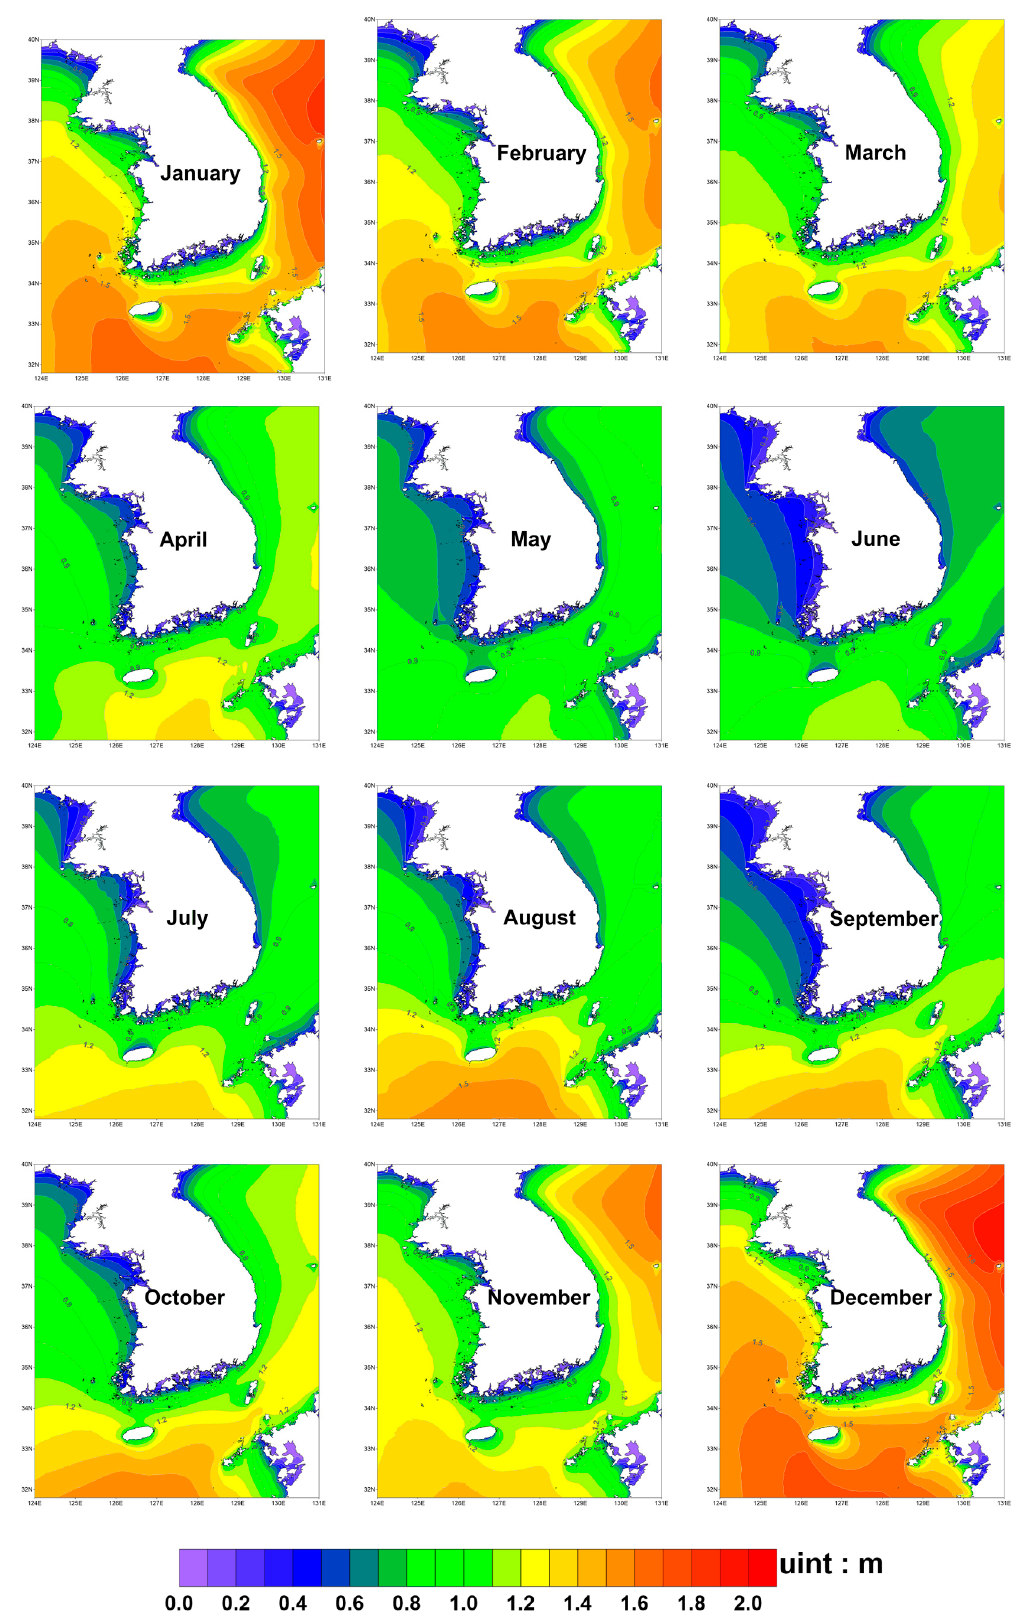
Figure 14. Monthly averaged wave height around the Korean Peninsula over 2007–2018.